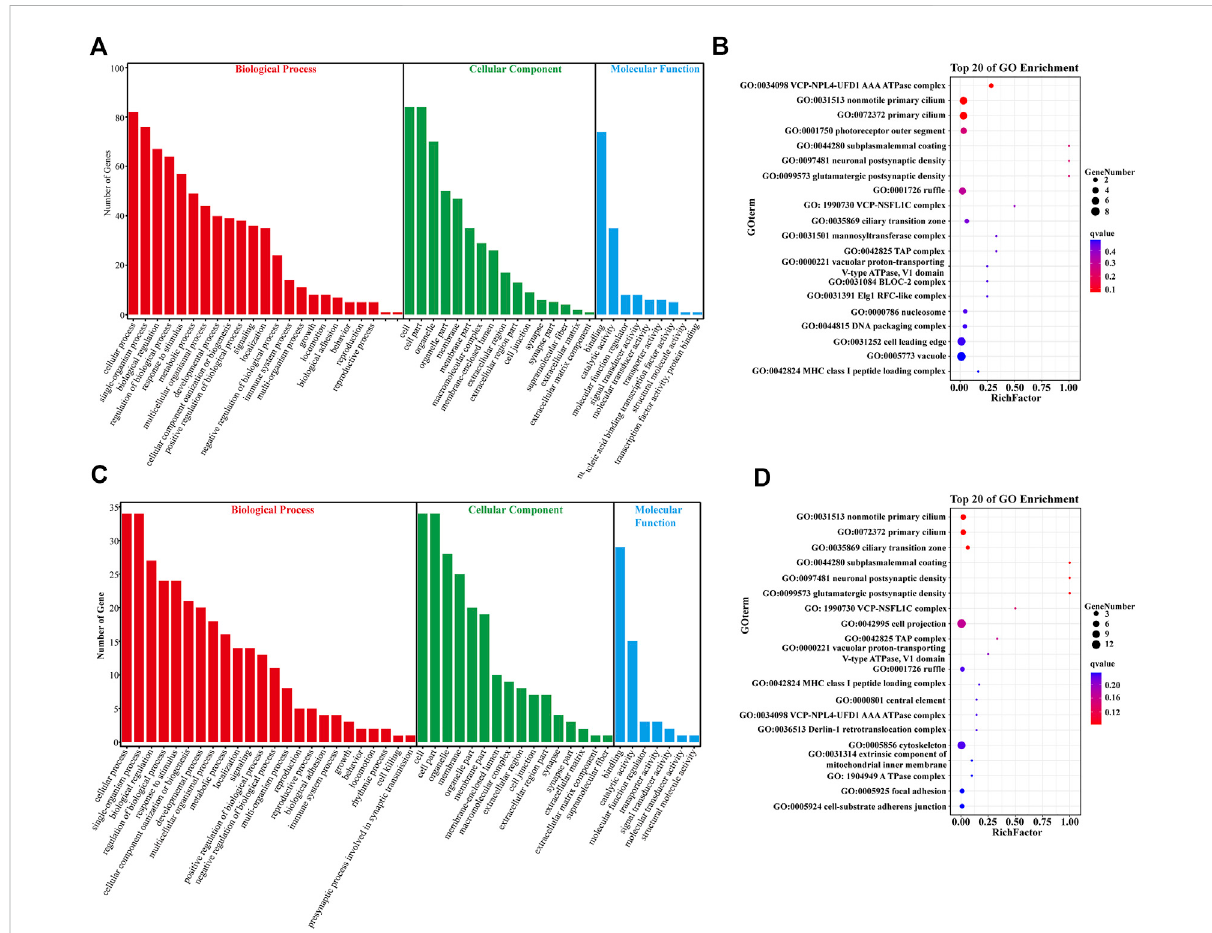
FIGURE 2 Geneontology (GO)analysisofDEGs. (A) GOpathwayanalysisofDEGsintheCMvs.EMSgroups. (B) Top20enriched termsbyDEGs intheCM vs.EMSgroups. (C) GOpathwayanalysisofDEGsintheCMvs.EMWgroups. (D) Top20enrichedtermsbyDEGsintheCMvs.EMWgroups.Thecolor of each dot represents the corrected p -value of the corresponding